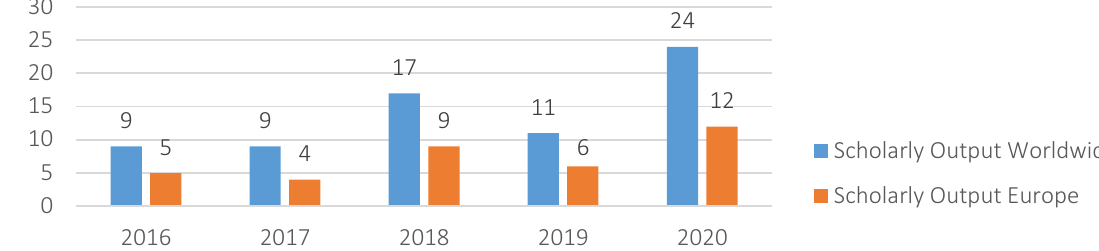
Figure 2. Number of publications in the Scopus database under the research area